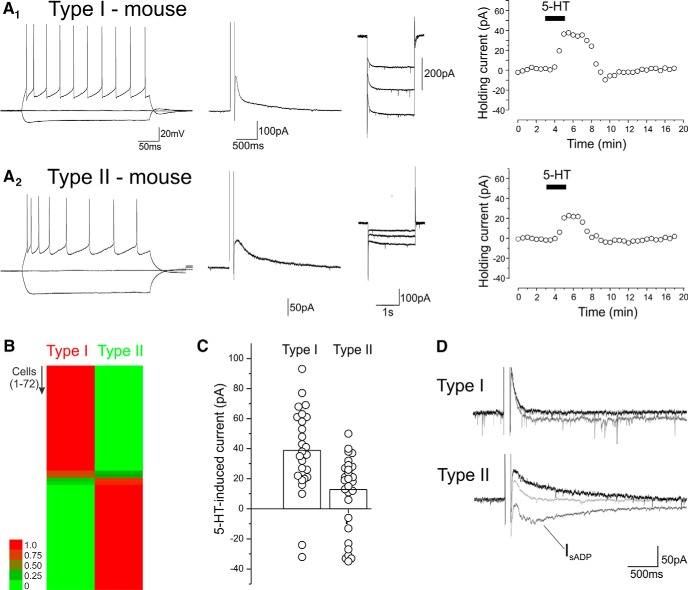
Type I and type II cells in L5 of the mouse mPFC. A1, A2, Electrophysiological characterization and response to serotonin administration (10 μm) in two L5 pyramidal cells, one classified as a type I and the other as type II by the Bayesian sorter. B, Heat map depicting the probability that each of the 72 cells tested belongs to the type I and type II classes as determined by Autoclass. The probability for each cell is color-coded as depicted in the scale bar. C, Summary graph plotting the amplitude of the peak serotonin-induced currents in the cells sampled. D, Effect of serotonin on IsAHP and IsADP in type I and type II cells. Traces were baseline subtracted for clarity. The type I cell responded to serotonin with a 69-pA outward current and the type II cell with a –24-pA inward current. Overall, in this group of cells, serotonin (10–30 μm) elicited a –14 ± 6.5-pA inward shift in the aftercurrent in type I cells and –27 ± 3.5 pA in type II cells (p < 0.01).